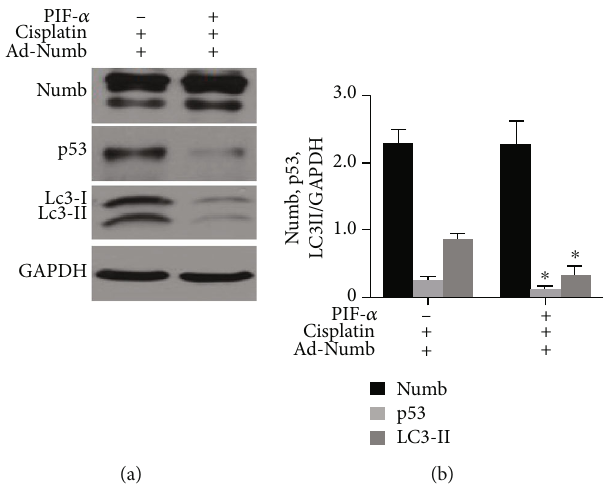
Figure 4: Numb activates Cisplatin-induced autophagy in p53- dependent pathway. NRK-52E cells were infected with Ad- Numb for 24h, then incubated with 20 μ M PIF- α or vehicle (DMSO) for 1 hour and followed by Cisplatin incubation for 6 hours. (a) The protein expression of Numb, p53, and LC3-II in cells of di ff erent groups as indicated, GAPDH was used as loading control. (b) Relative expression of Numb, p53 ,and LC3-II to GAPDH was represented in graphic. Data are shown as means ± SD. n =3. ∗ P < 0 : 05 DMSO-treated Ad-Numb-infected cells with Cisplatin